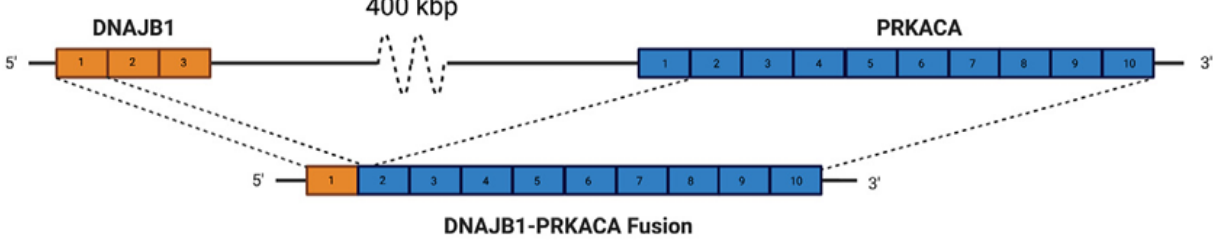
Figure 3: The oncogenic driver of fibrolamellar carcinoma is the fusion of DNAJB1 and PRKACA on chromosome 19. The fusion product connects exon 1 of DNAJB1, which encodes the N-terminal of the DnaJ heat-shock domain, to exons 2–10 of PRKACA, which encode most of the kinase domain and the C-terminus. DNAJB1–PRKACA gene fusion activates the kinase activity of protein kinase A catalytic subunit